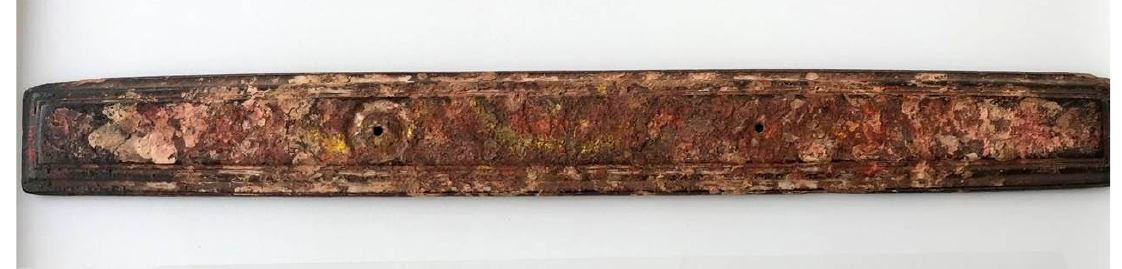
Figure 16. Top of the top wooden cover. Perfection of Wisdom in Eight Thousand Lines: A ṣṭ as ā hasrik ā Prajñ ā p ā ramit ā -s ū tra , 1119. India and Nepal. Paper and pigments on wood. Overall: 6.5 × 57 × 1.5 cm. Cleveland Museum of Art, purchase from the J. H. Wade Fund, 1938.301.